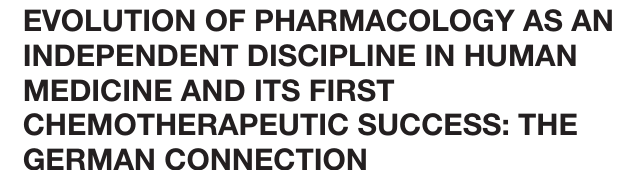
FIGURE 7 | Buchheim, Schmiedeberg, and Ehrlich and the foundation of modern pharmacology. (Left) Rudolf Buchheim (1820–1879) was a German pharmacologist, now recognized as the “father of pharmacology.” He played a decisive role in the transition from Materia Medica to pharmacology by introducing quantitative in vitro tests (bioassays) and by his adaptation of the reference work of the time on Materia Medica by the Englishman Jonathan Pereira; Buchheim deleted the obsolete chapters. His pupil was Oswald Schmiedeberg (1838–1921) (Middle) . Of Baltic origin, Schmiedeberg was an emblematic professor of pharmacology at the University of Strasbourg. He is regarded as the “father of modern pharmacology.” His main contribution was to train many future world-renowned pharmacologists, including four future Nobel Prize winners. Paul Ehrlich (1854–1915) (Right) is the father of chemotherapy. He discovered arsphenamine (Salvarsan), the first effective drug treatment for syphilis. He also developed methods of staining pathogens, including the tubercle bacillus. Ehrlich’s staining method was adapted to introduce the Gram stain, as it is still used today. In 1908 he received the Nobel Prize in Physiology or Medicine for his contributions to immunology, a prize he shared with Elie Metchnikoff (